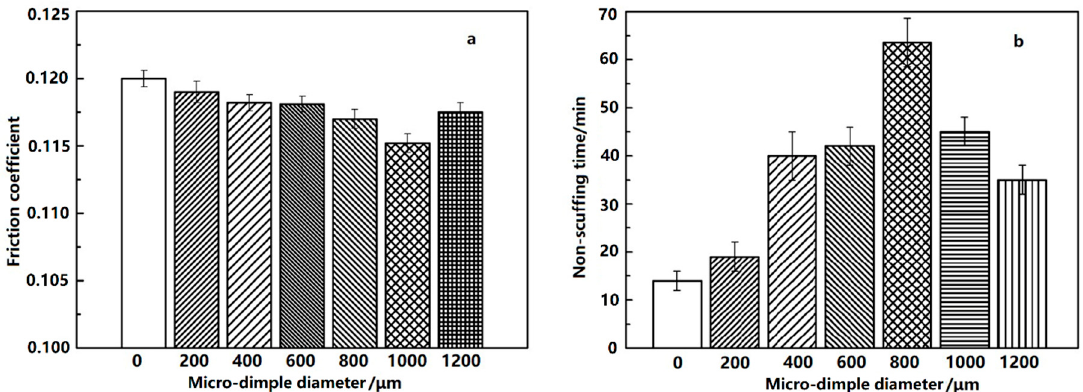
Figure 8. Friction coefficient at the shocking dead center ( a ) and non-scuffing time ( b ) with different micro-dimple diameters.